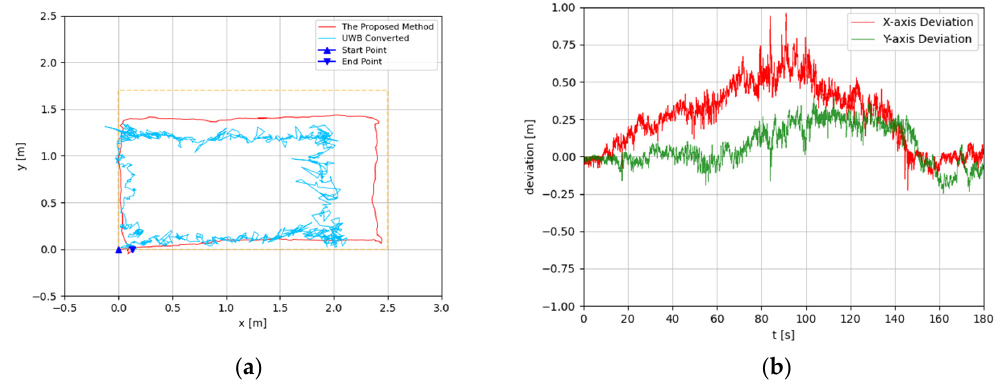
Figure 9. ( a ) Trajectory of rectangle-shaped the second test; ( b ) Positioning comparison of rectangle- shaped the second test.